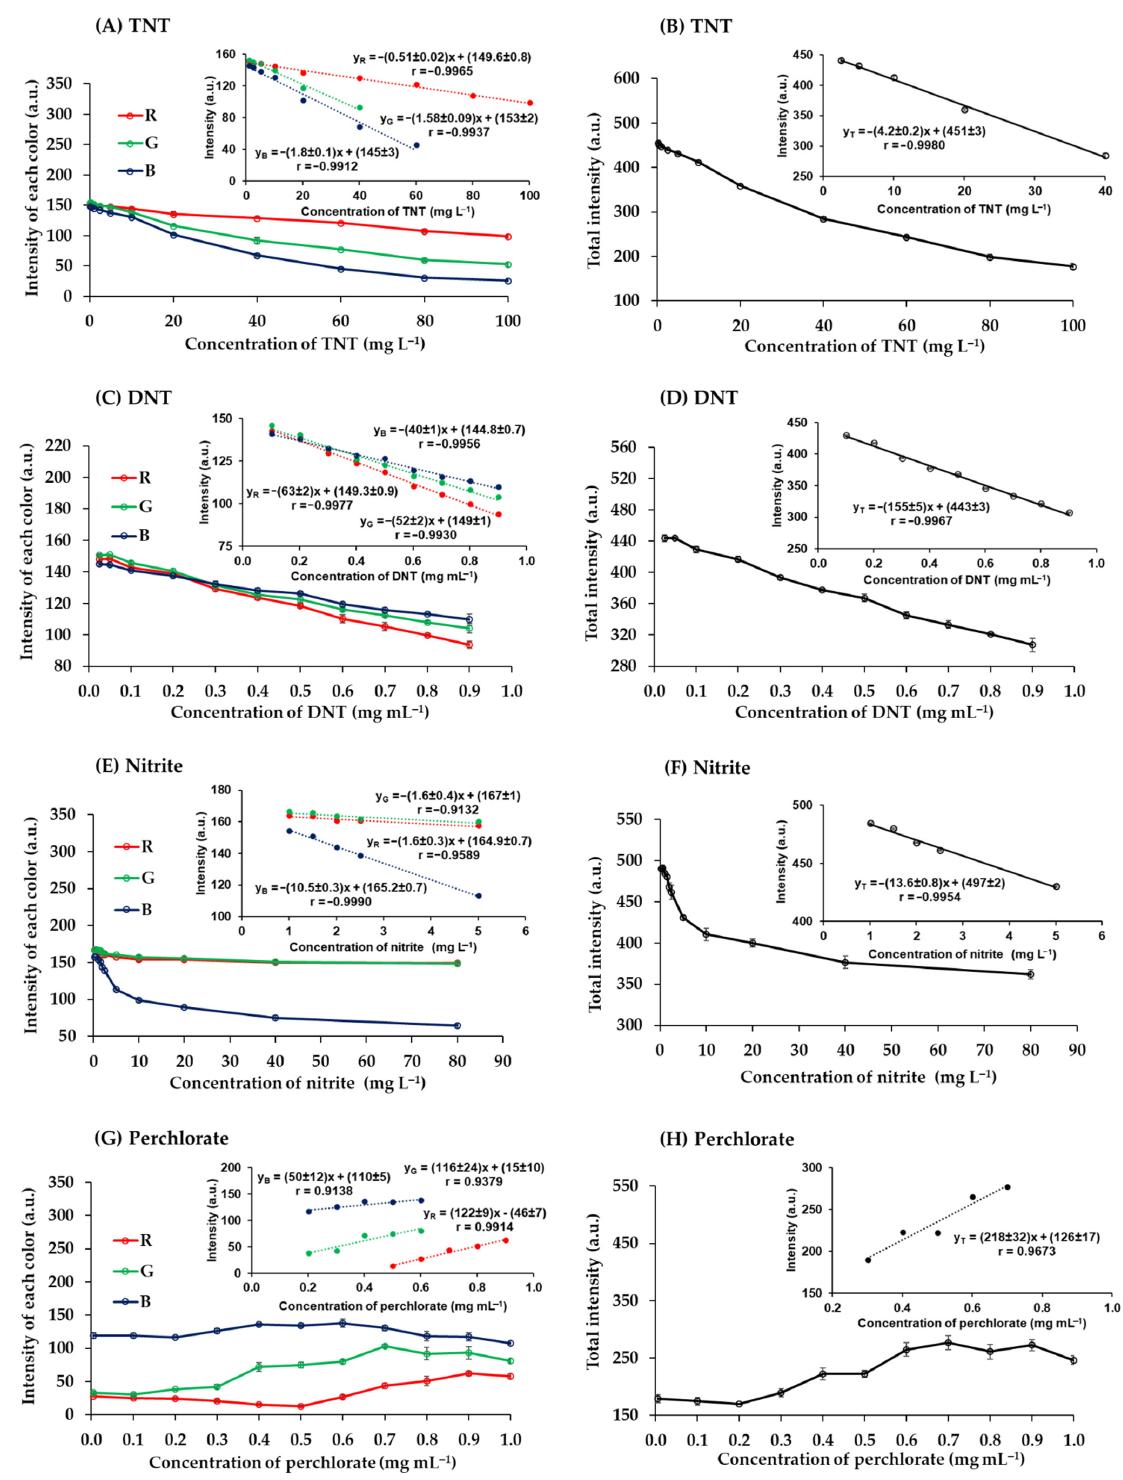
Figure 6. Relationship between the intensity of each color and the concentration of ( A ) TNT, ( C ) DNT, ( E ) nitrite, and ( G ) perchlorate and the relationship between the total intensity and the concentration of ( B ) TNT, ( D ) DNT, ( F ) nitrite, and ( H ) perchlorate.